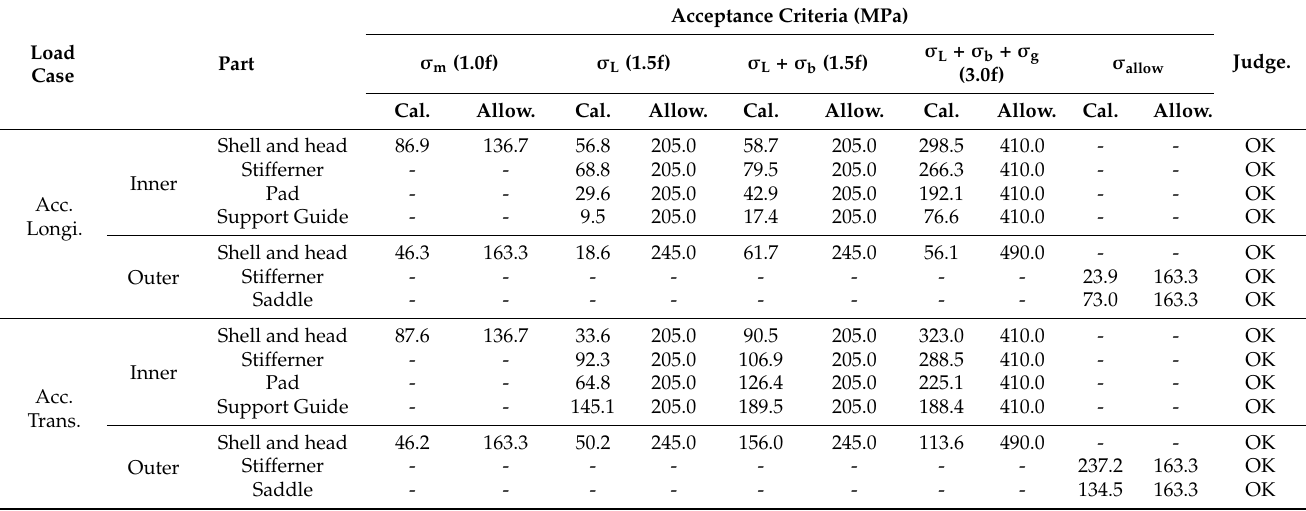
Table A1. Summary of structural analysis result for